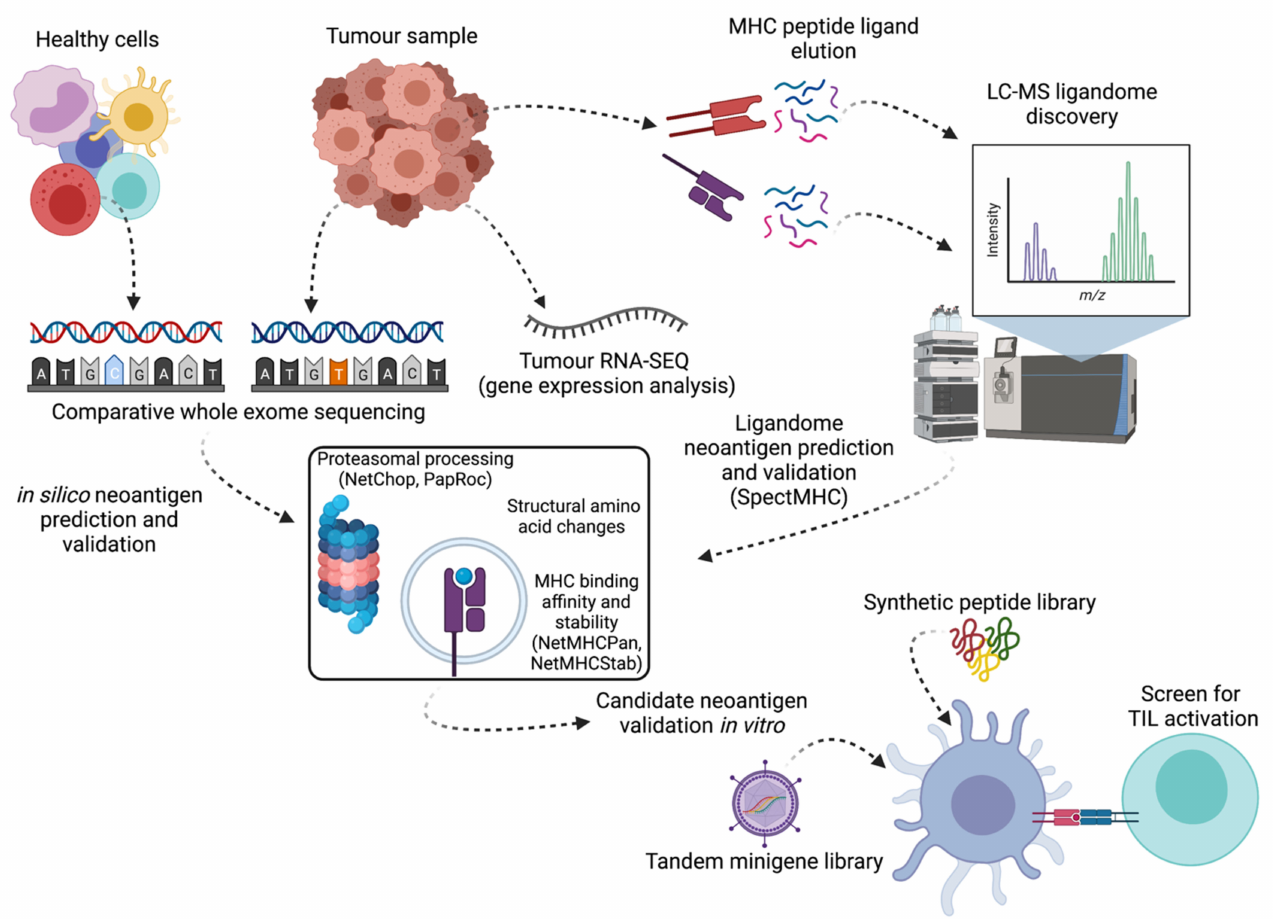
Figure 2. Overview of neoantigen identification and validation pipelines. Matched whole-genome or whole-exome sequencing data is used to identify sequence differences between healthy and tumour-derived DNA. Concurrently, the eluted tumour MHC-I/II ligandome can be assessed via LC-MS, and tumour RNA expression data is collected to validate the presence and expression level of mutated transcripts. Resulting putative neoantigenic peptide sequences are triaged and prioritized using bioinformatic tools to inform likely proteasomal processing, degree of difference from matched wild-type peptide, and MHC binding affinity and stability based on donor HLA haplotype. Finally, selected candidates are expressed as tandem minigene libraries or synthesized as long peptides and the capacity of patient T cells to recognize transduced or peptide-loaded autologous APC and autologous tumour cells is assessed. Algorithms listed are cited